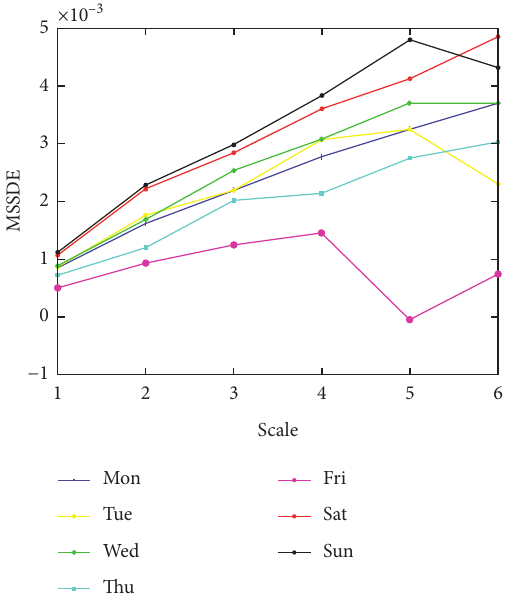
Figure 4: The result of analysis on the traffic day using the proposed